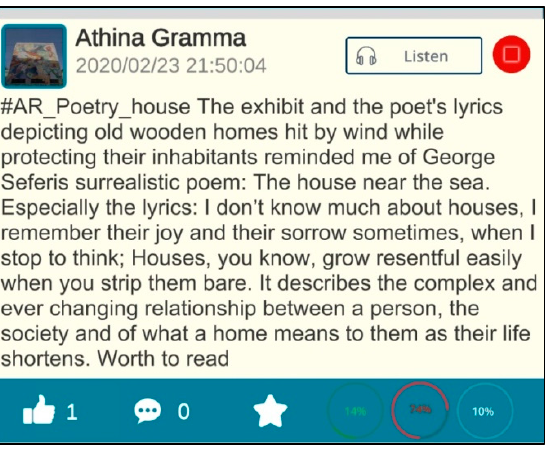
Figure 15. Example of a post text sentiment analysis computational result. The three loading bars at the bottom right of the picture along with their corresponding percentages estimate the positive, negative, and neutral feeling derived from the content of the post.